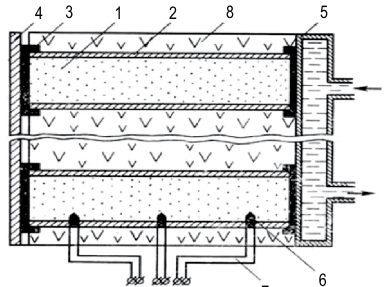
Fig. 1. The thermo-osmotic installation scheme for research of non-isothermal moisture transfer parameters: 1 – a soil sample; 2 – a tube; 3 – a cover; 4 – a plate; 5 – the heat exchanger; 6 – thermo-sensitive elements; 7 – conclusions of conductors; 8 – a heat-insulating